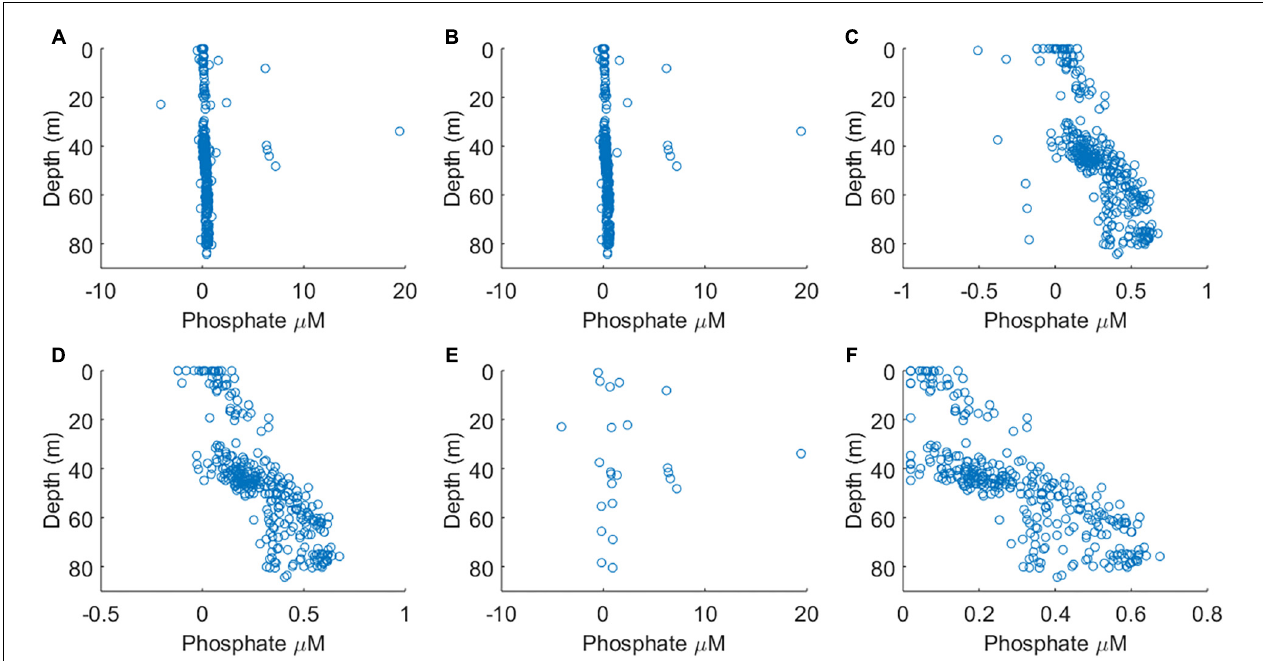
FIGURE 5 | The results of data screening steps carried out, panels (A–D) are in sequence. Note changing horizontal axis scales. (A) The complete dataset. (B) Dataset after the removal of data generated from poor calibrations (see Figure 4 ). (C) Dataset after the removal of concentrations > 1 µ M PO 43 − . (D) Dataset after the removal concentrations < –0.20 µ M. (E) All outliers and data resulting from poor calibrations, which were removed from final dataset. (F) The quality controlled data